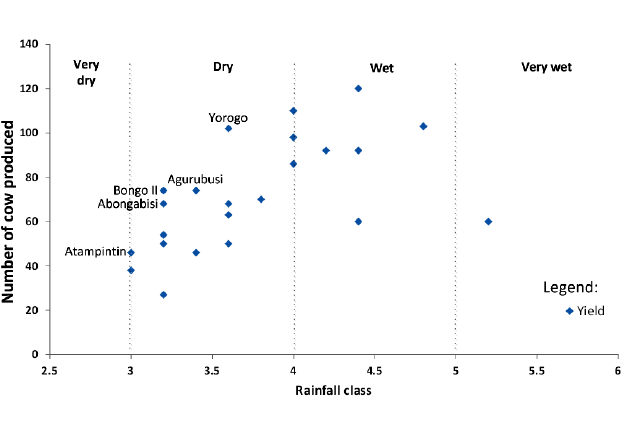
The mean percentage of patches that were classified as desert, i.e., degraded land, by the end of the game was approximately 11%. Figure 6 presents a summary of the final percentages of desert patches. Only 7 of the games (30%) with mean annual rainfall in the dry category had below-average percentages of desert